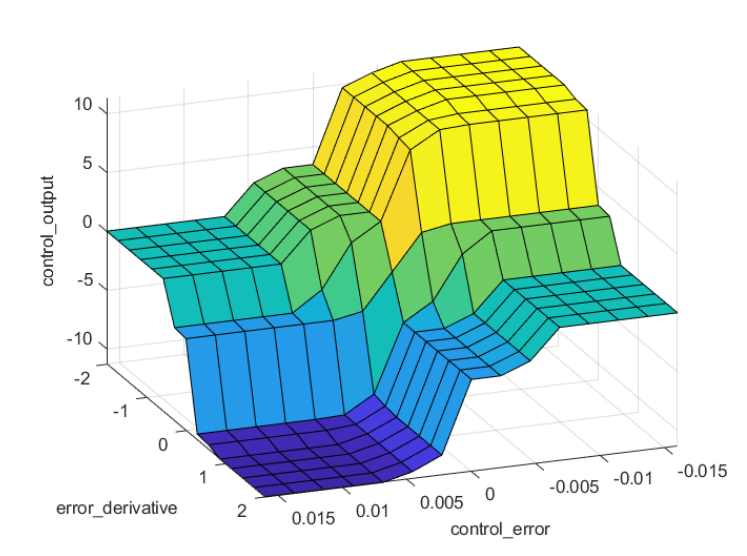
Figure 5. The control surface of the fuzzy logic controller.